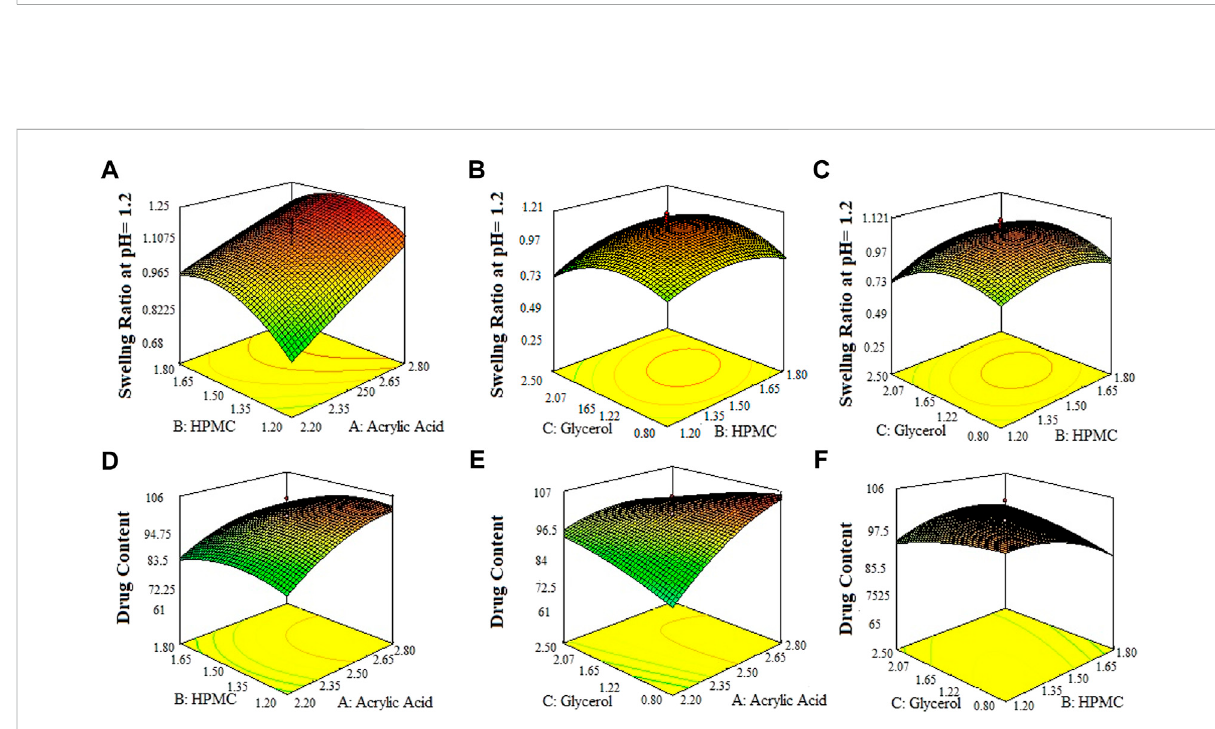
FIGURE 3 3DsurfaceplotsindicatingtheeffectofvariousconcentrationofHPMC-K100,glycerolandacrylicacidonswellingratioofSPHsin0.1NHClpH = 12 (A – C) and drug content in SPHs (D – F)